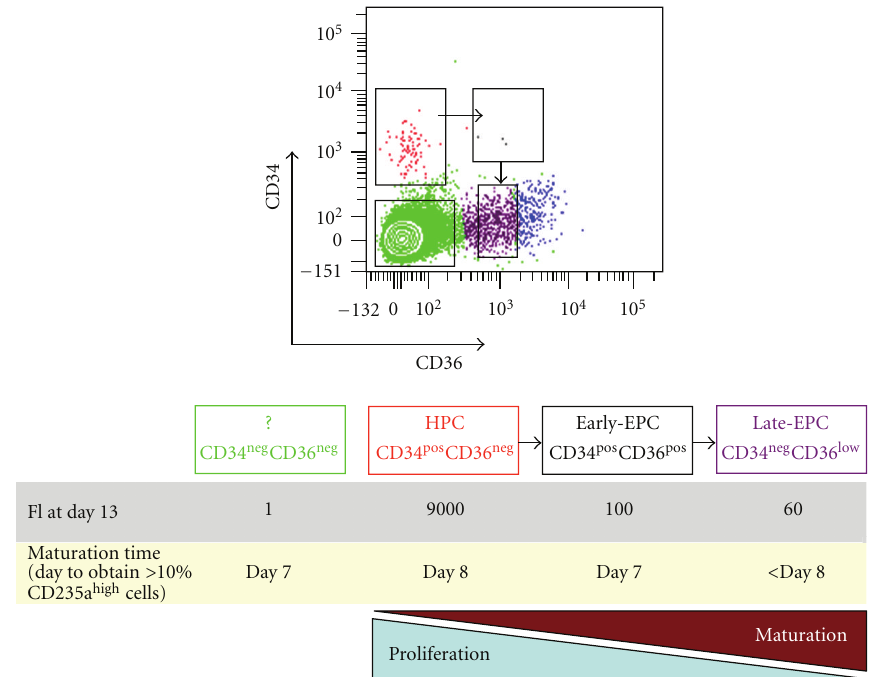
Figure 3: A model for the hierarchical relationship between progenitor cells with erythroid proliferation potential present in AB MNC. This model is based of the proliferation potential (as indicated by the FI) and of the speed of maturation (as indicated by the time required to generate significant numbers, > 25%, of mature CD235a pos EBs) of the di ff erent populations. See text for further